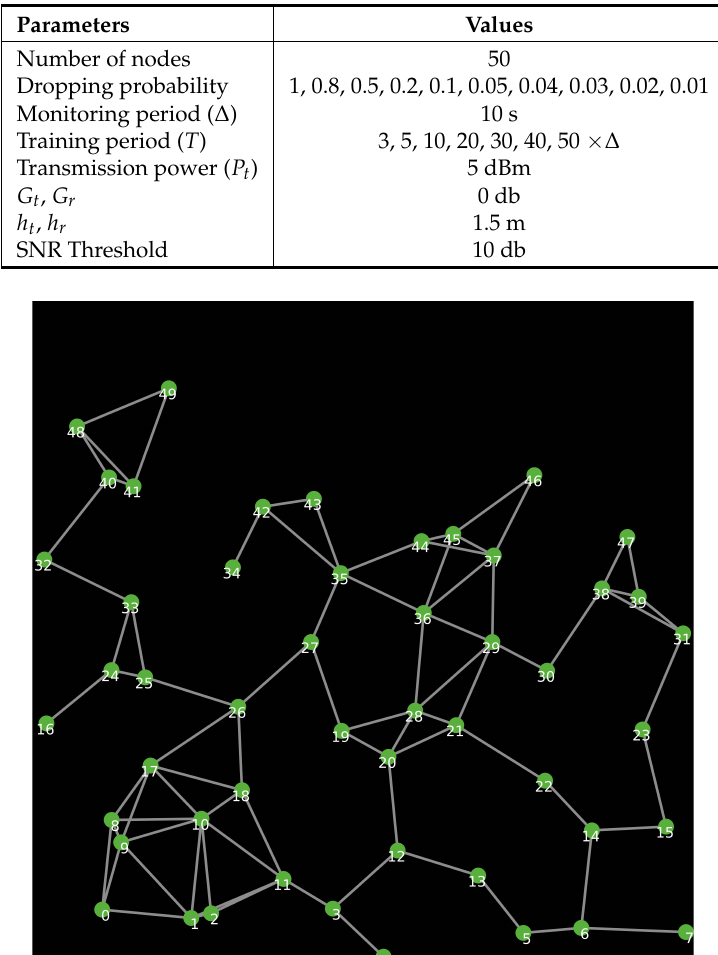
Table 2. Simulation Parameters.